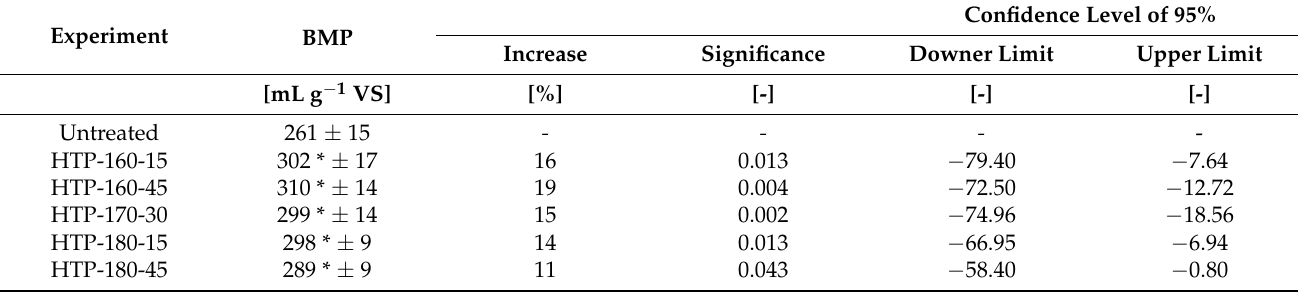
Table 6. Finale methane yields of untreated and hydrothermally pretreated (HTP) wheat straw samples, including increase in BMP, significance (Games–Howell post-hoc) and confidence level of